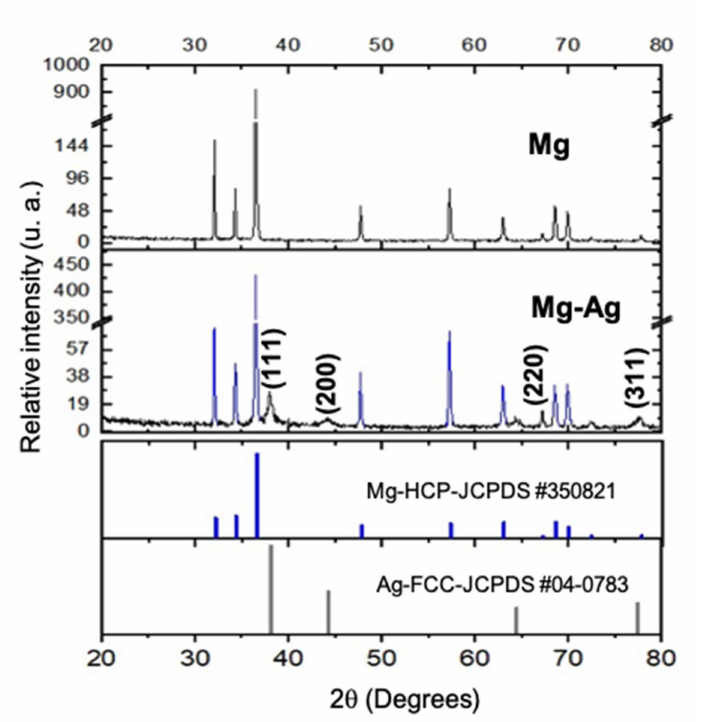
Figure 12. XRD spectra of Ag-NPs deposited on Mg-Ca0.3 surface (from 10 − 3 M, t = 6 min). The